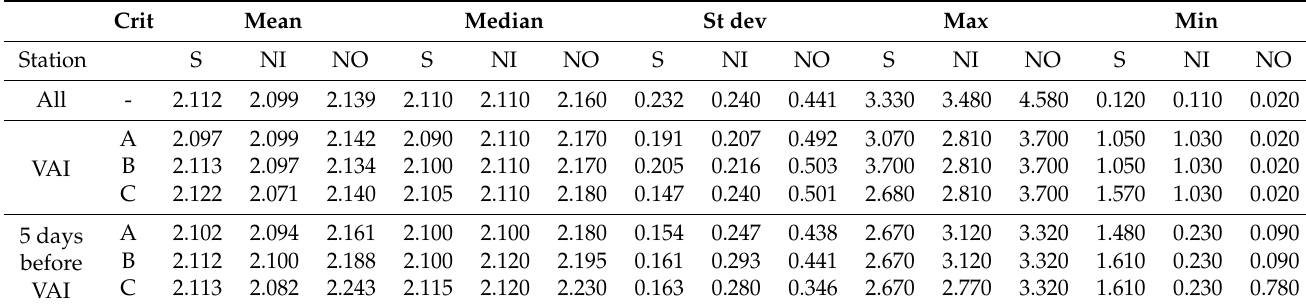
Figure 11. Minimal night TEC values distribution for IGS Noto, criteria C, for the day of VAI ( a ) and 5 days before VAI ( b ). Basic statistical indicators of minimal night TEC values for all stations are presented in Table 2. Data are shown for the whole dataset, as well as compared to the same indicators for VAI and 5 days before VAI. Table 2. Statistical indicators of minimal night-time TEC values during all criteria ( Crit ) as calculated for IGS San Fernando ( S ), IGS Nicosia ( NI ) and IGS Noto ( NO ) for the whole dataset ( All ), the day of VAI and 5 days before